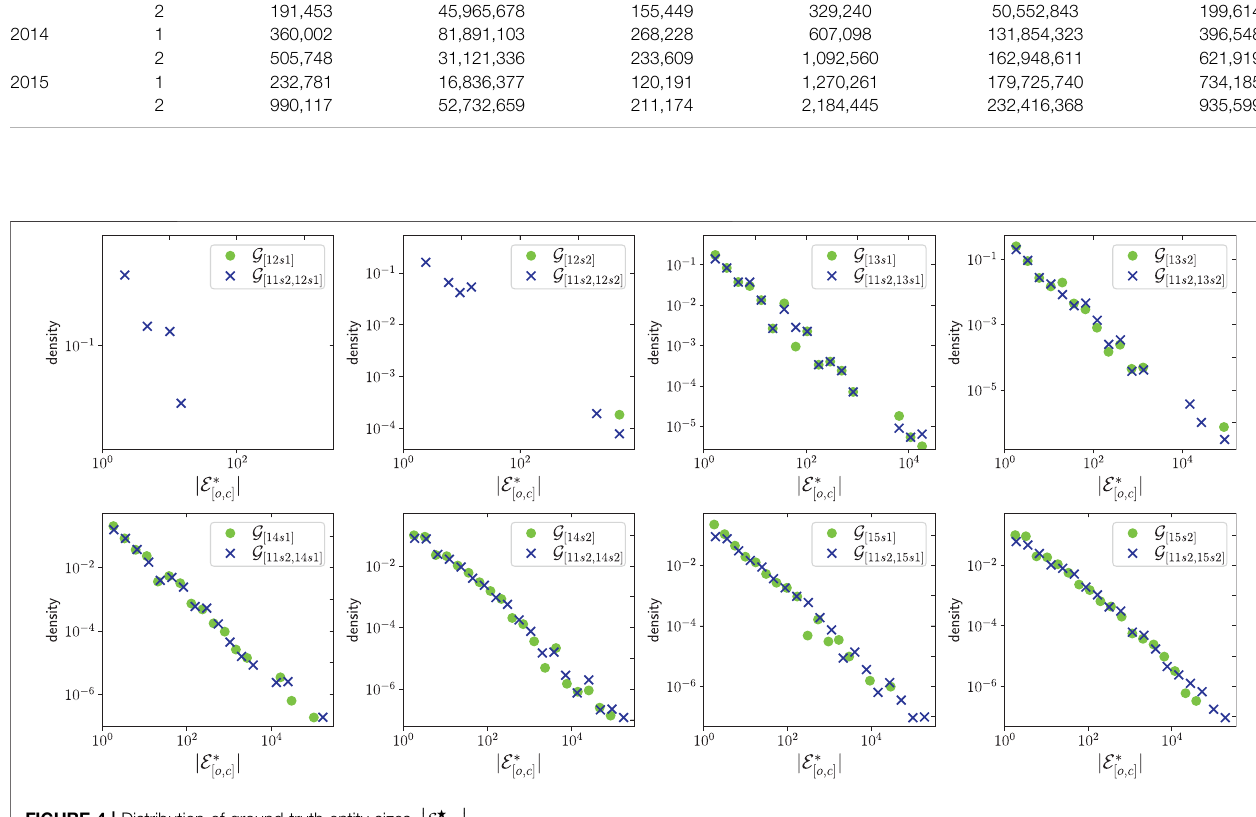
(cid:1)(cid:1)(cid:1)(cid:1)(cid:1) (cid:1)(cid:1)(cid:1)(cid:1)(cid:1) E + . [ o , c ]